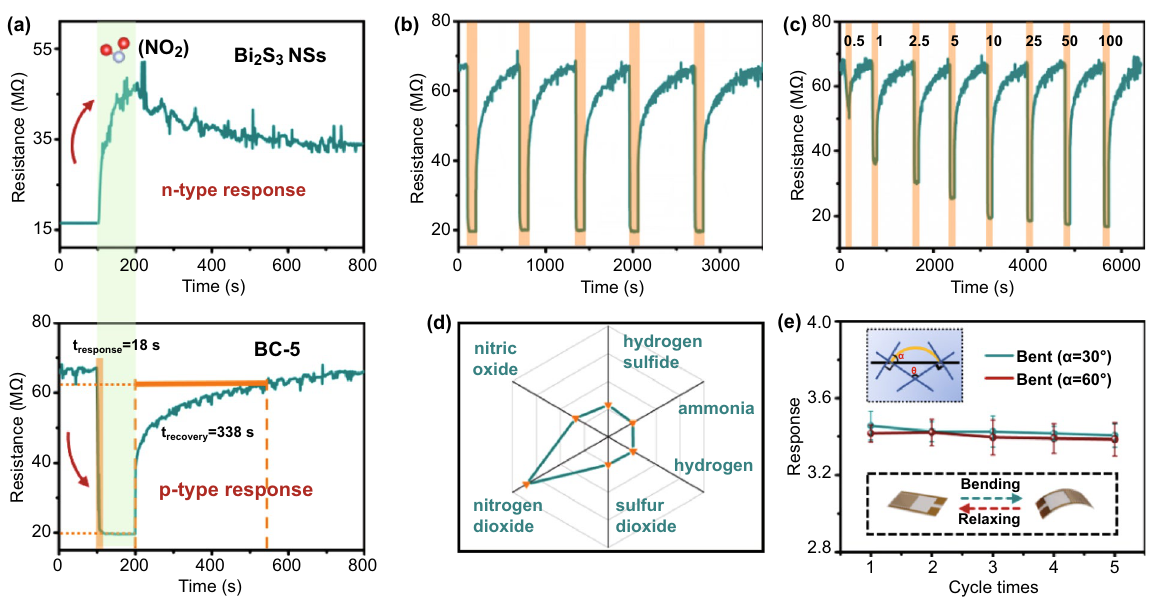
Fig. 5 NO 2 sensing performances BC-5-based sensor. a Resistance variation for the device to NO 2 at 10 ppm concentration. b Response-recov- ery curve of the device for 5 cycles to 10 ppm NO 2 . c Transient response-recovery curve for the device to NO 2 with different concentrations. d Selectivity for the device to 10 ppm different target gases. e Response graph and response error bar for the device to 10 ppm NO 2 with different bending